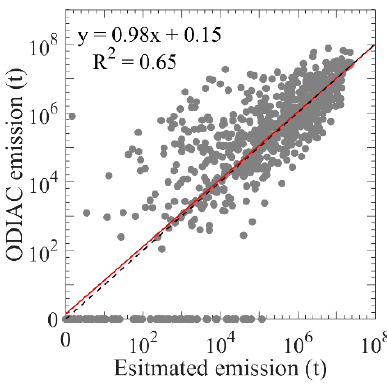
Figure 6. Scatterplot between estimated CO 2 emission using mapped-XCO 2 data and the actual ODIAC emission in 2015, in which red line is the regression line between estimated emission and ODIAC emission, and black dotted line is the 1:1 line.